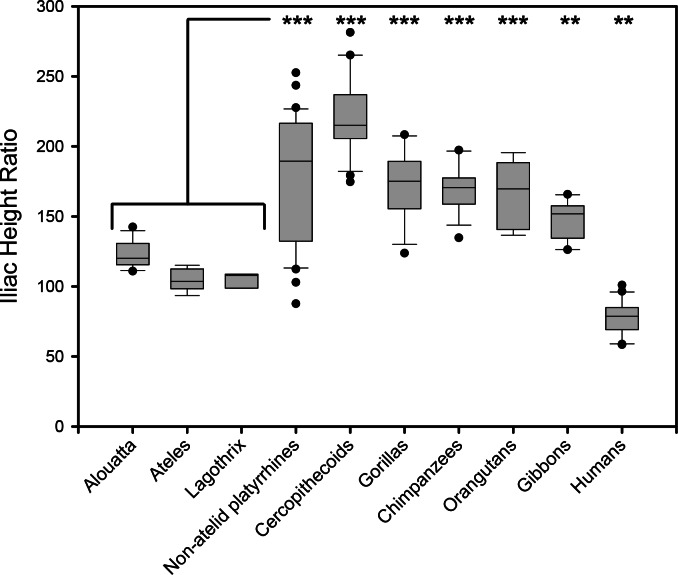
Box plot illustrating relative iliac height across anthropoids.Iliac Height Ratio = (Iliac height X 100)/Acetabular breadth. Analysis of Variance (ANOVA) demonstrates highly significant difference between means whether atelids are grouped as a family or as individual species. Significance values indicated from Bonferroni posthoc pairwise test between combined atelids and other groups (∗∗, p < 0.01; ∗∗∗, p < 0.001). Atelids that engage in caudal suspension most often have the lowest iliac height except for humans. The three New World monkey lower outliers are specimens of Chiropotes santanus, Aotus vociferans, and Callicebus sp.